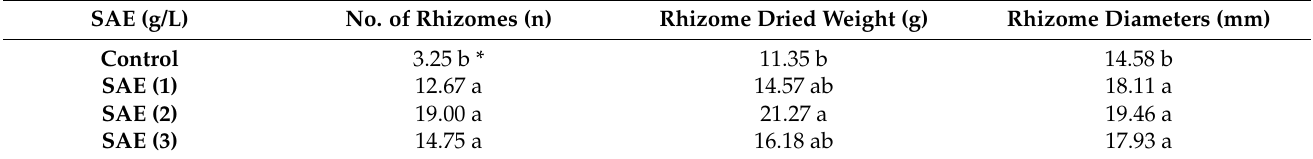
Table 6. Effects of Spirulina platensis aqueous extract (SAE) treatments on the number (n) of rhizomes, rhizomes dried weight and rhizome diameter (mm) of C. longa